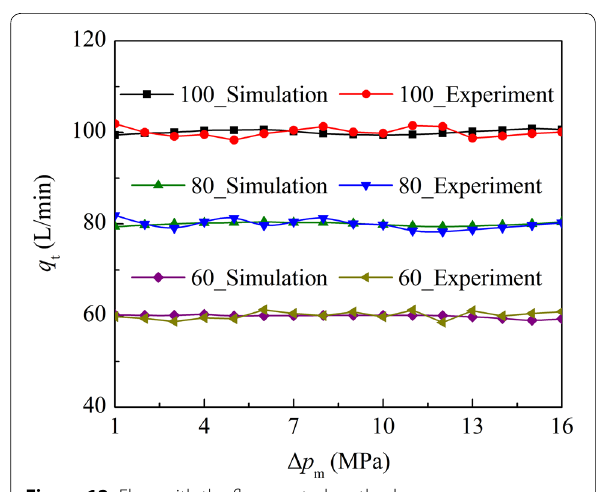
Figure 12 Flow with the flow control